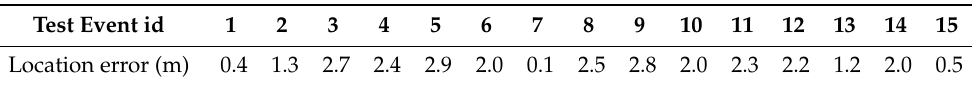
Figure 6. Location results of the test source 4 by using the GBRTM location method for different homogeneous velocity models. ( a ) Location results obtained by the GBRTM location method with different homogeneous velocity models. The pink star denotes the true source location and the small green stars represent the locations determined by the GBRTM method with homogeneous velocity models increasing from 3400 m/s to 4700 m/s. The blue star indicates source location determined by the GBRTM method with the minimum location error under a homogeneous velocity model with the value of 4100 m/s. ( a1 , a2 ) are enlarged subplots of the ( a ), and the numbers correspond to the used homogeneous velocity model. ( b ) Location errors of the GBRTM method using different homogeneous velocity models. ( c ) Stacking amplitude imaging at points near the true source location based on autocorrelation imaging condition when the background velocity is 4100 m/s. The green star and the pink star indicate the location obtained by the GBRTM method and true source location. Table 1. Location errors (m) of the 15 test events based on the GBRTM location method using the correct 2D velocity model shown in Figure